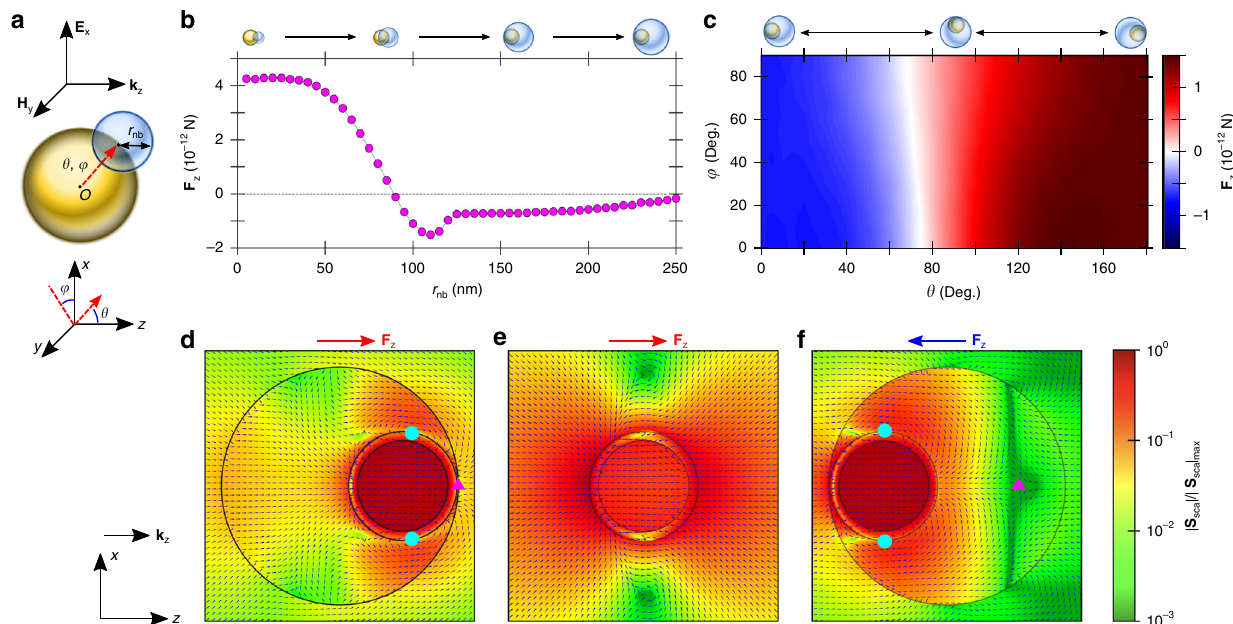
Fig. 2 Optical force on an Au NP with a nanobubble. a Schematic of an Au NP with a nanobubble. The Au NP (yellow sphere) consists of a 100 nm- diameter silica core and a 10 nm-thick Au shell. The nanobubble with a radius of r nb is attached to the surface ( θ , φ ) of the Au NP, where θ and φ are, respectively, the polar and the azimuthal angles in the polar coordinate with the origin ( o ) at the center of the Au NP. E x , H y , and k z depict the electric fi eld, the magnetic fi eld, and the wavevector of the incident planewave, respectively. b The calculated optical force in the z -direction ( F of r nb . Here, θ = 0 o , φ = 0 o and the amplitude of E x is 2.6 × 10 6 V m − 1 , corresponding to the laser in the experiment. The insets illustrate the schematic con fi gurations of Au NP with a nanobubble with different r nb . c The calculated F z as a function of θ and φ . Here, r nb = 130 nm and the amplitude of E x is 2.6 × 10 6 V m − 1 . On top of the contour, schematic con fi gurations of Au NP with a nanobubble as a function of θ are illustrated. d – f The directions and normalized magnitudes of Poynting vectors of scattered fi elds S sca for the structures of d r nb = 130 nm and θ = 180 o , e without a nanobubble, and f r nb = 130 nm and θ = 0 o . Directions of F z are also